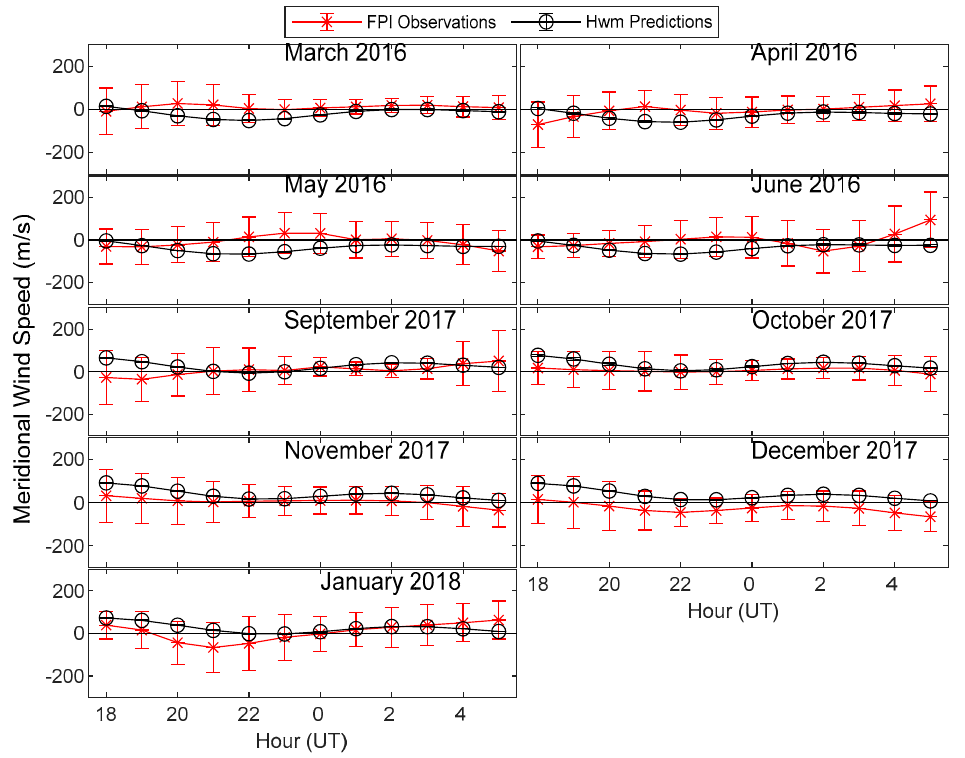
Figure 4. Meridional winds in Nigeria for March 2016 to January 2018. The red plots represent the FPI measurements, while the black plots represent corresponding HWM-14 predictions. The vertical error bars indicate the standard deviations of the observations. Adapted with permission from Ref. [4]. 2021, Rabiu et